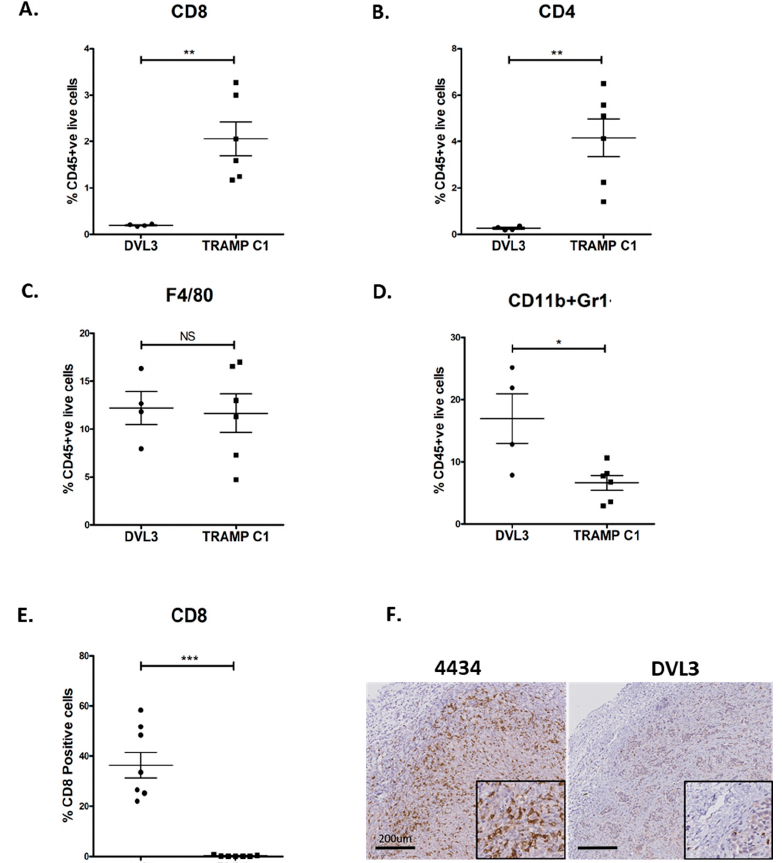
Figure 2. The DVL3 model generates immunosuppressive, ‘cold’ tumours similar to the TME seen clinically in prostate cancer. Flow cytometry was performed on DVL3 and TRAMP-C1 subcutaneous, syngeneic tumours taken 4-6 weeks post engraftment or when they reached the treatment size (100-200 mm 3 ). DVL3 tumours had significantly fewer ( A ) cytotoxic (CD8+) and ( B ) helper T cells (CD4+) when compared with the TRAMP-C1 model. ( C ) There was no difference in the proportion of macrophages (F4/80) between the two models. ( D ) However, the population of myeloid derived suppressor cells (MDSCs, CD11b+Gr1+) was significantly increased in the DVL3 compared to TRAMP-C1 tumours. ( E ) Quantification of immunohistochemical staining for CD8+ T-cells in inflamed syngeneic murine (4434 Braf 4006E ) melanoma model compared to the non-immunogenic DVL3 murine prostate cancer model shown as a percentage of total cells as quantified by haematoxylin. ( F ) Representative IHC staining comparing 4434 (Braf 4006E ) melanoma vs DVL3 prostate tumour demonstrating lack of CD8+T-cells within the tumour microenvironment in the DVL3 tumours. In 4434 (Braf 4006E ) melanoma model CD8+ T-cells are uniformly distributed, including the central of the tumour. Data represents mean ± SEM of n = 4–9 independent murine tumors as indicated by points on each graph. * denotes p ≤ 0.05, ** denotes p ≤ 0.01, *** denotes p < 0.001 as determined by Mann-Whitney, non-parametric testing.